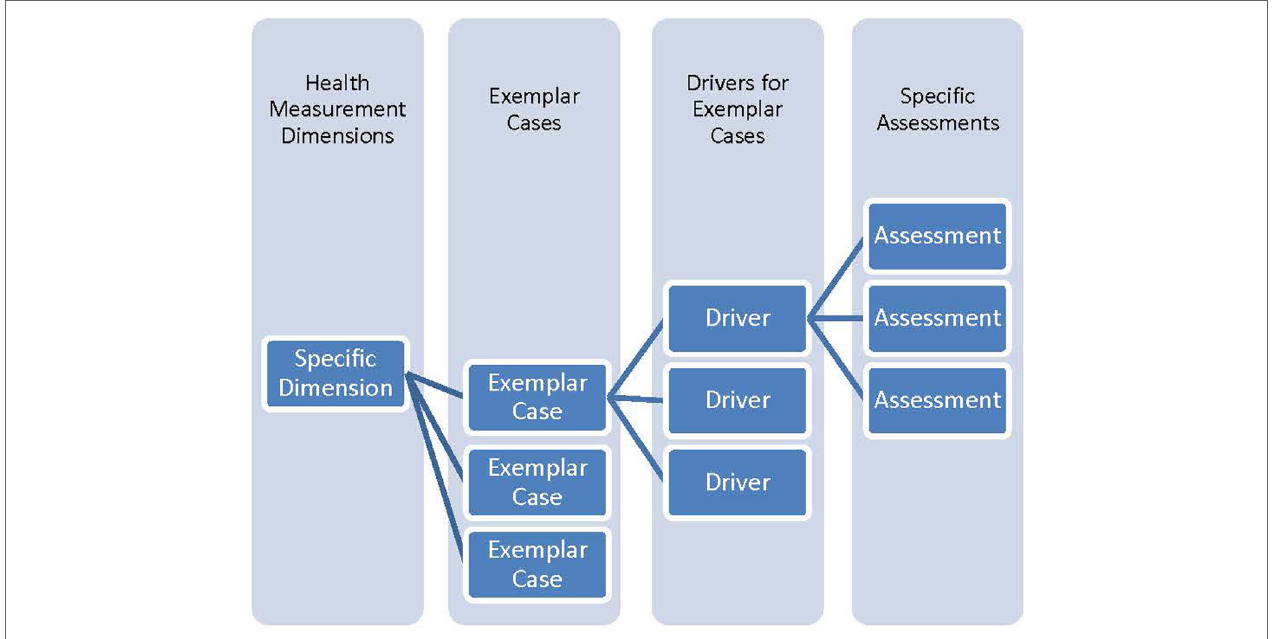
FiGURe 1 | Hierarchy of information from specific assessments to health dimensions. Relationships between health, dimensions, exemplar cases, drivers, and specific assessments is a many to many